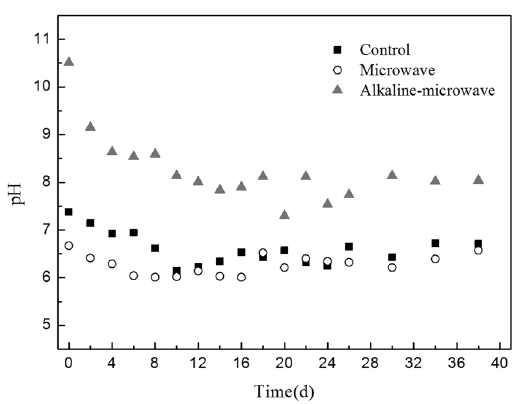
Figure 2. Changes of pH during the anaerobic digestion after different